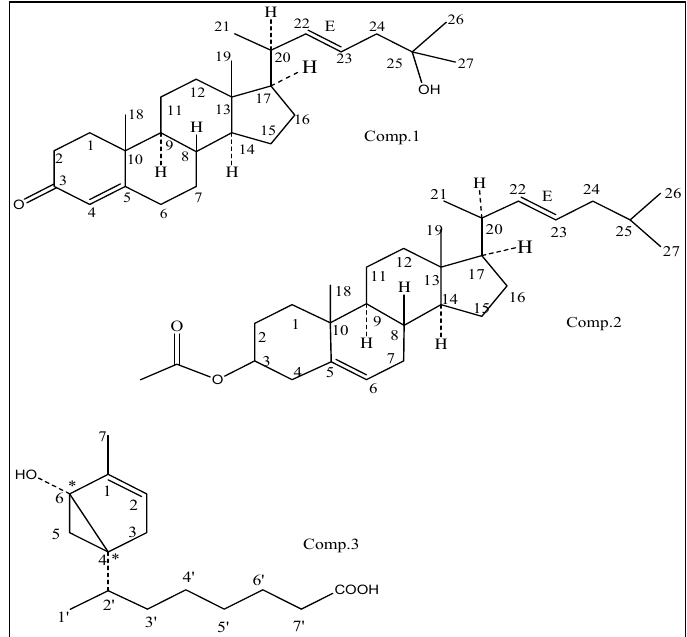
Figure 1. Structures of compounds 1 – 3 from arthropod scorpion, B. martensii kirsch.